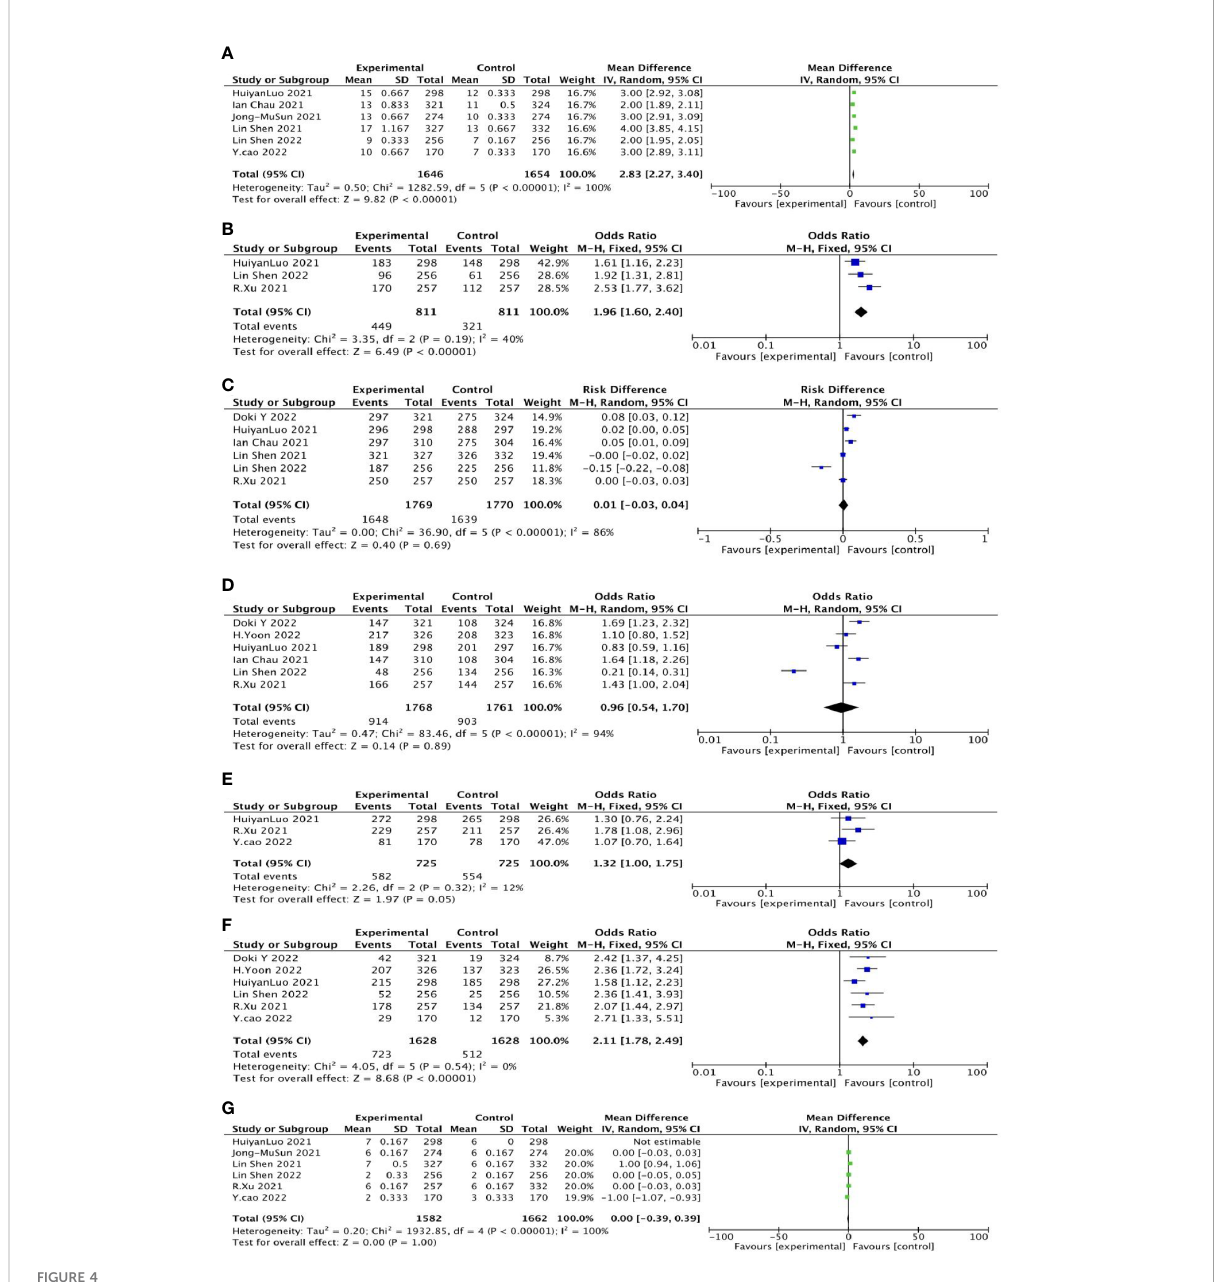
FIGURE 4 General forest plot for each outcome in fi rst-line